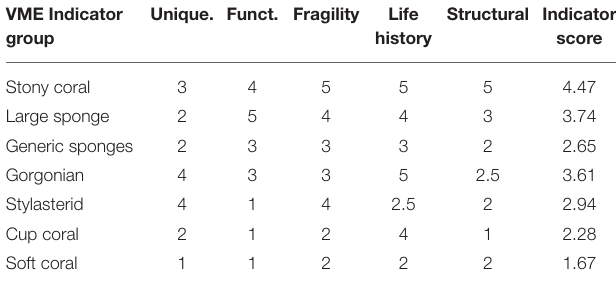
TABLE 2 | Indicator scores for VME taxa groups, based on the degree to which each group fits the FAO VME criteria (FAO, 2009): uniqueness or rareness, functional significance, fragility, life-history that makes recovery difficult, and structural